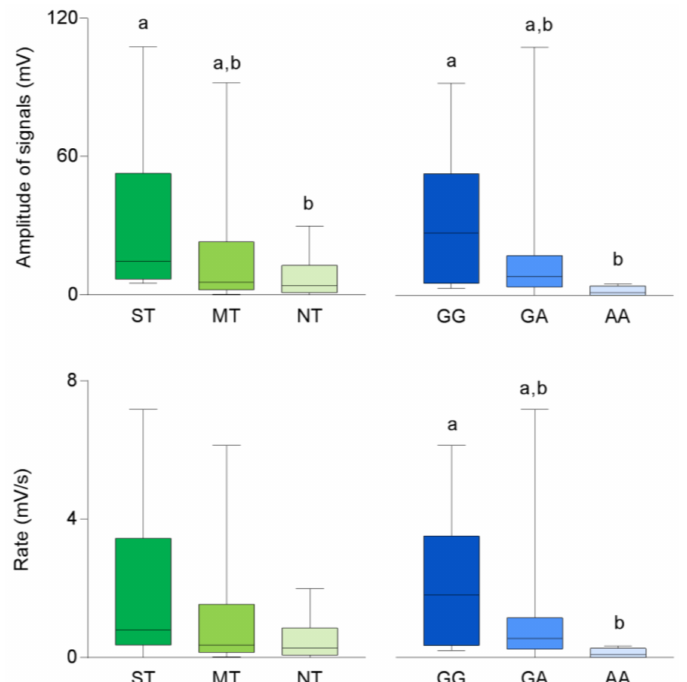
Figure 5. Box-and-whisker plots showing the minimum, first quartile, median, third quartile, and maximum of each data set of amplitude and rate of signals evoked in super-tasters (ST; n = 10), medium tasters (MT; n = 13) and non-tasters (NT; n = 12); and in volunteers with genotypes GG ( n = 9), GA ( n = 20) and AA ( n = 6) of CD36 by oleic acid (30 µ L) taste stimulation. Different letters indicate a significant difference ( p ≤ 0.05; Fisher LDS or Duncan’s test subsequent one-way